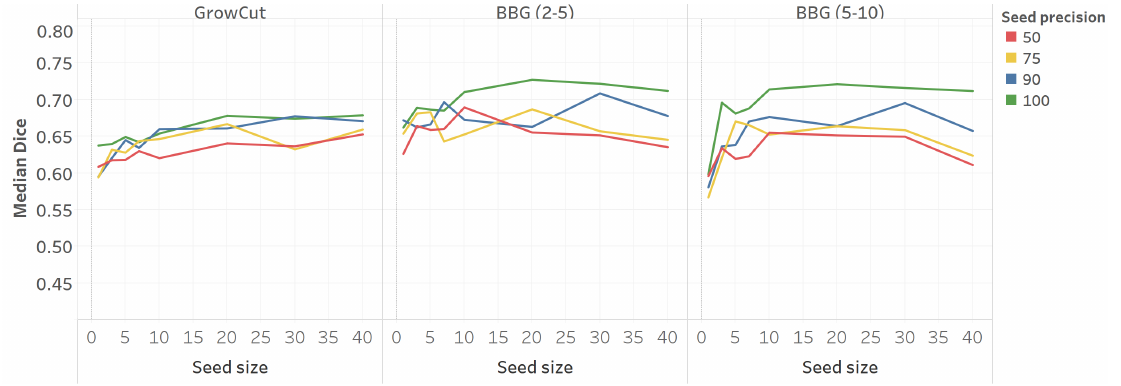
Figure 4. Median Dice value as a function of seed size and seed precision (MMWHS dataset). BBG, band-based GrowCut.